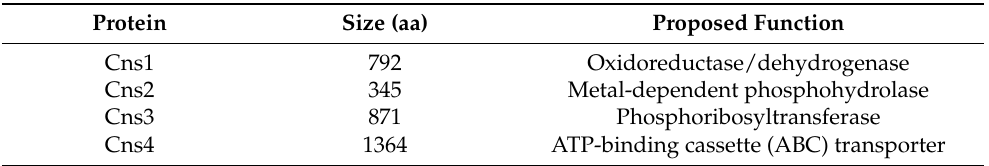
Figure 5. ( A ): the biosynthesis gene cluster of PNT and COR in the Cordyceps militaris . ( B ): the bio- synthesis gene cluster of PNT and COR in the Aspergillus nidulans . Table 4. The proposed functions of proteins in the biosynthesis gene cluster of PNT and COR in the Cordyceps militaris